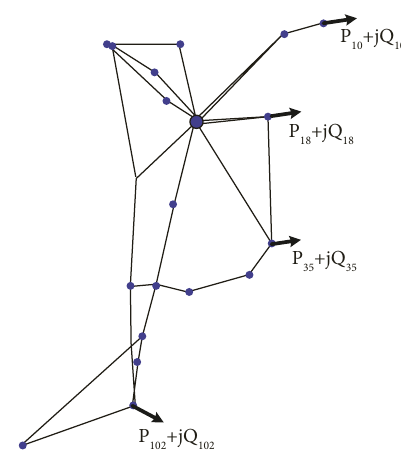
Figure 16: Internal area with external